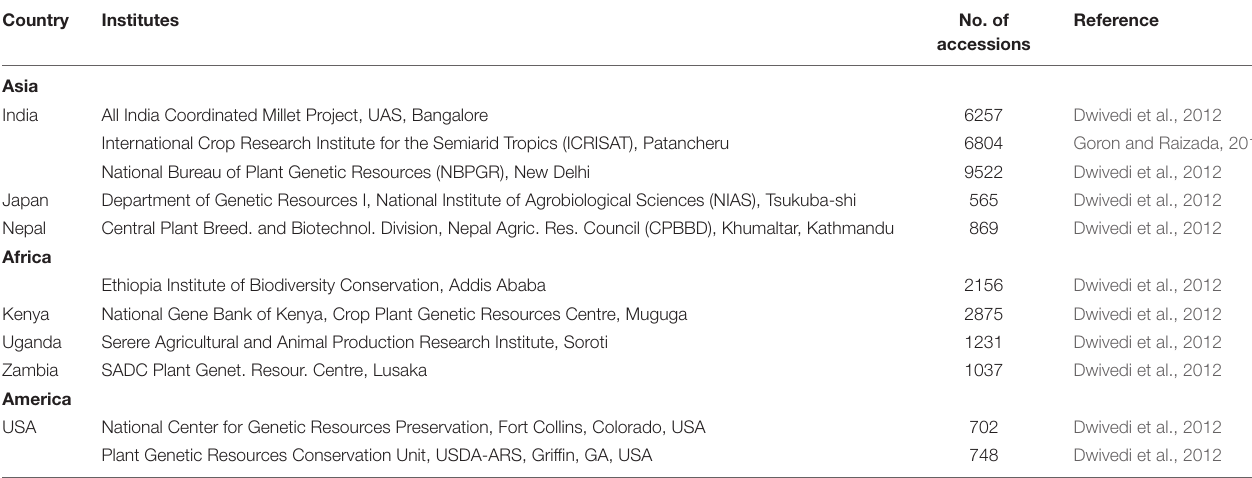
TABLE 1 | Number of worldwide significant cultivated germplasm collection of finger millet preserved in national and international gene banks.